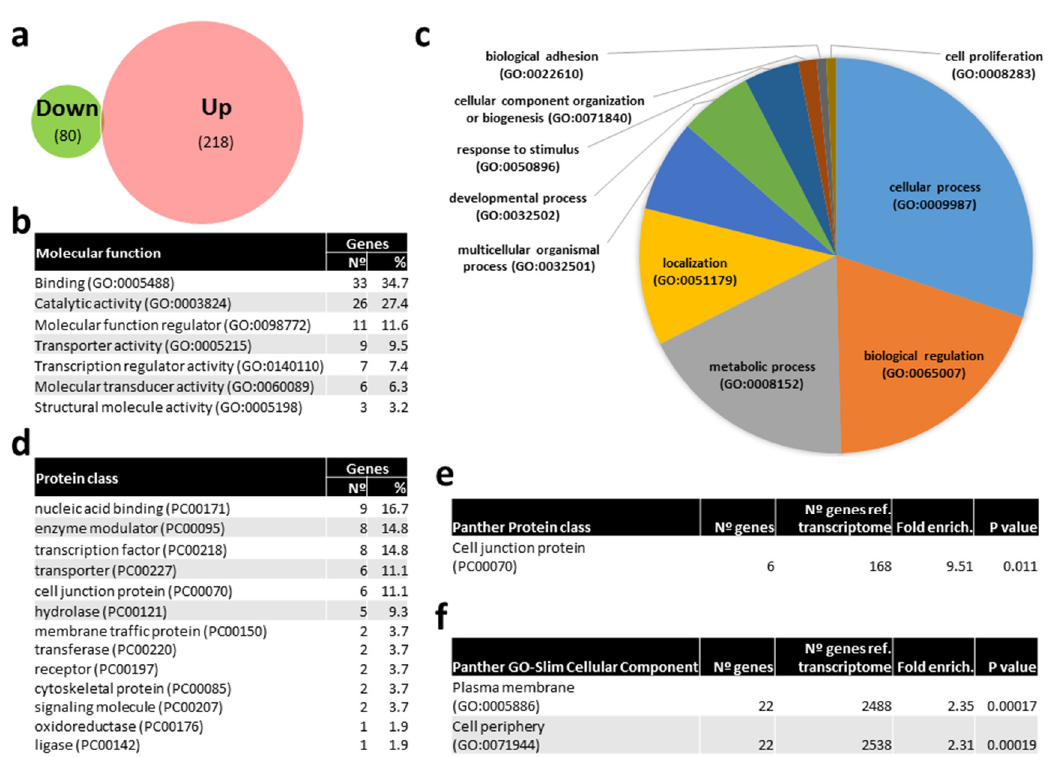
Figure 8. Venn diagram of predicted mRNA targets of miRNAs differentially expressed (DE) with kisspeptin treatment in blood plasma of Senegalese sole females and gene ontology (GO) analysis. ( A ) Venn diagram with the number of predicted mRNAs targeted by DE miRNAs. ( B ) List of GO molecular functions represented by predicted mRNAs targeted by DE miRNAs. ( C ) Pie chart of GO biological process of predicted mRNAs targeted by DE miRNAs. ( D ) List of GO Protein classes represented by predicted mRNAs targeted by DE miRNAs. ( F ) List of overrepresented Panther Protein classes ( E ) and GO-Slim Cellular Component of predicted mRNAs targeted by DE miRNAs showing the number of genes, the fold enrichment and the p value.